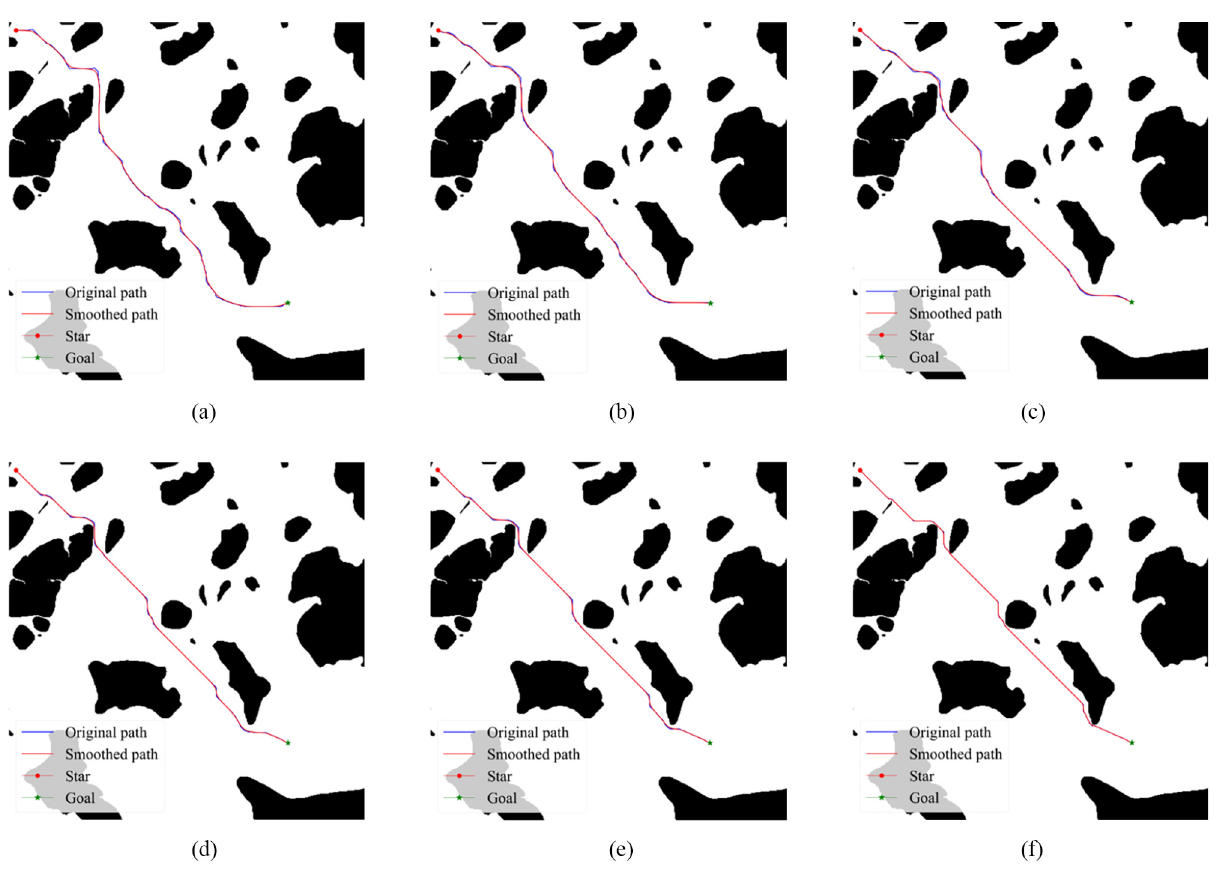
Figure 9 Path planning results under different navigation boundaries